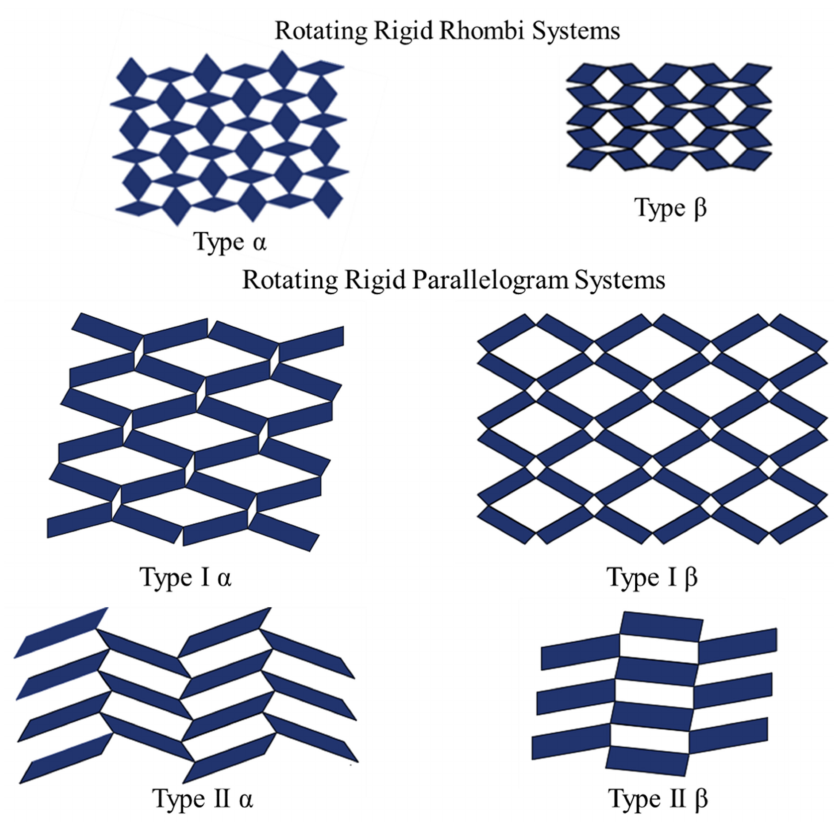
Figure 20. Rotating rhombi and rotating parallelogram systems; adapted from